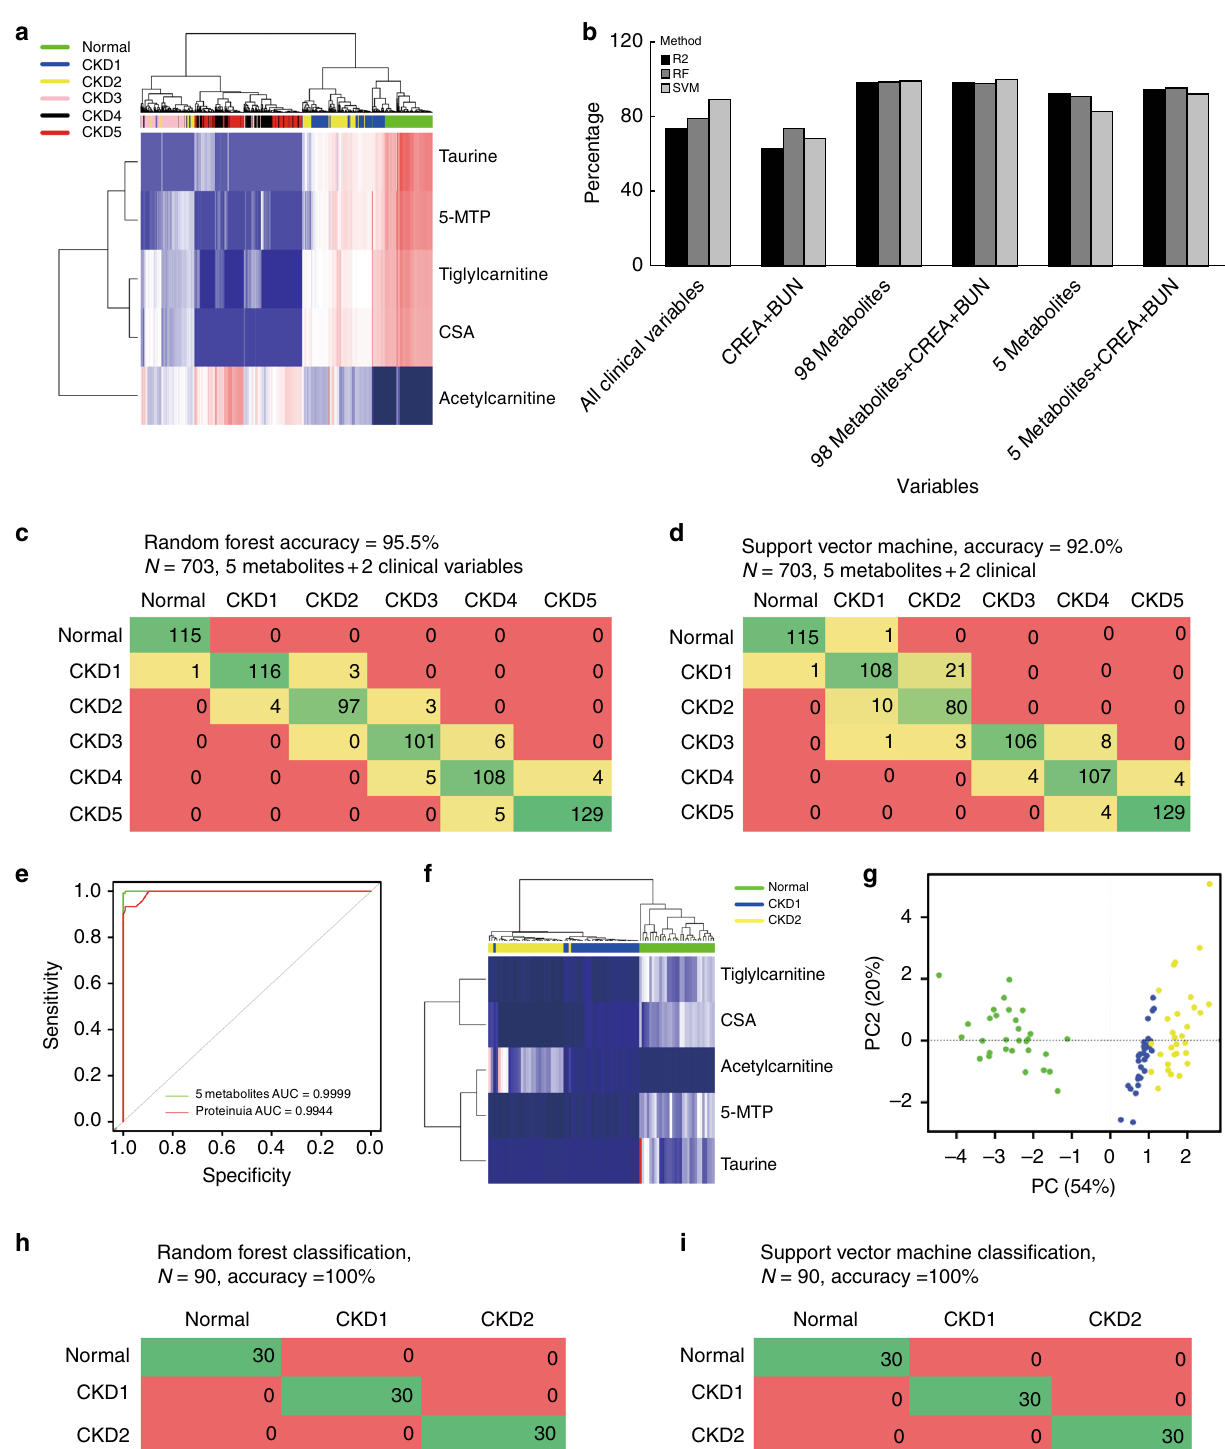
All fi ve metabolites exhibited abundance level shifts in directions concordant with results from training dataset (Fig. 4a, b). PCA, OPLS-DA, and heatmap showed that post-treatment patients with CKD2 could be separated from pre-treatment patients with CKD2 by the combination of proteinuria and the fi ve metabolites (Fig. 4c – e) with sensitivity and speci fi city of being 90.0 and 80.0%, respectively (Fig. 4f). Similar results were also observed by using only the fi ve metabolites (Fig. 4g – j). ROC analyses showed that all fi ve metabolites and proteinuria had high AUC (Fig.